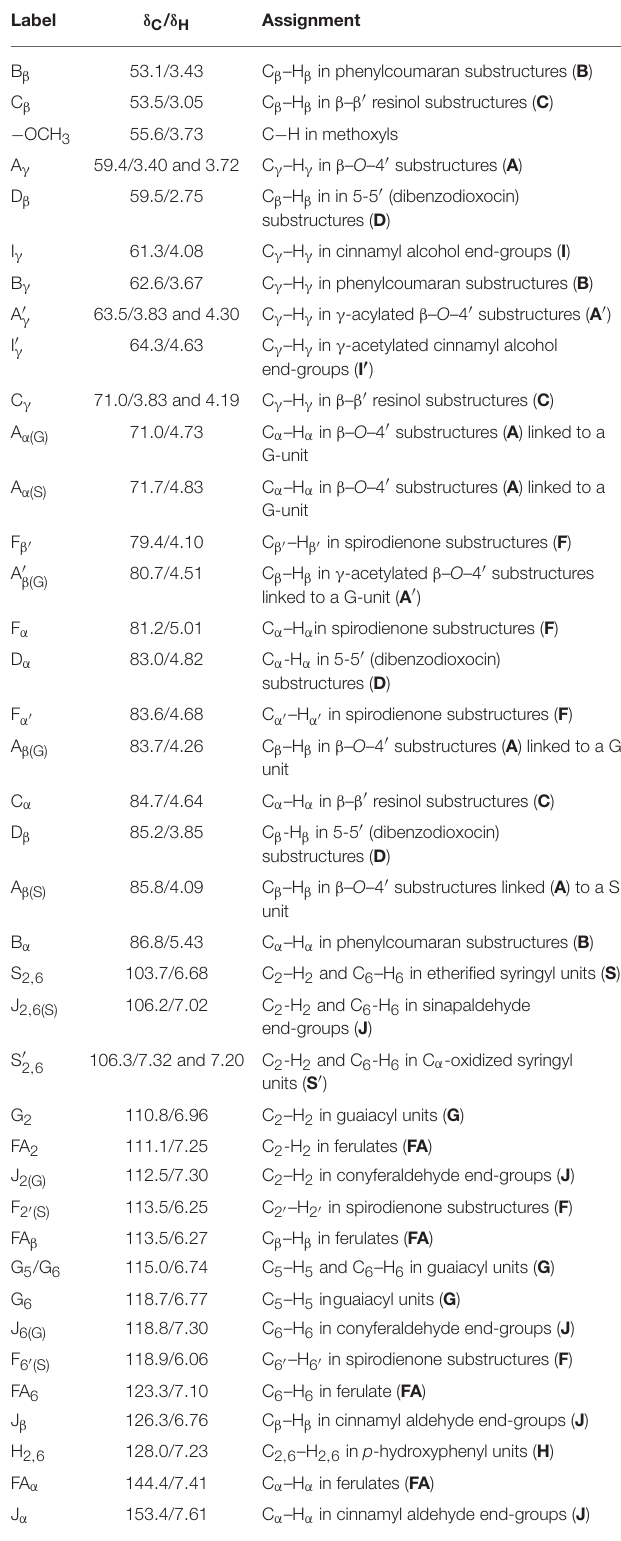
TABLE 3 | Assignments of the lignin 13 C– 1 H correlation peaks in the 2D-HSQC spectra of whole cell walls and of the corresponding isolated milled lignins from cork, phloem and xylem of Quercus suber